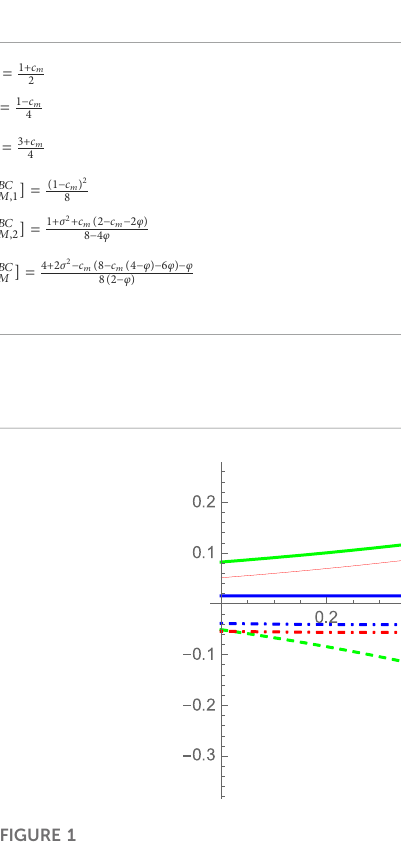
TABLE 2 The equilibrium outcomes of BC scenario.